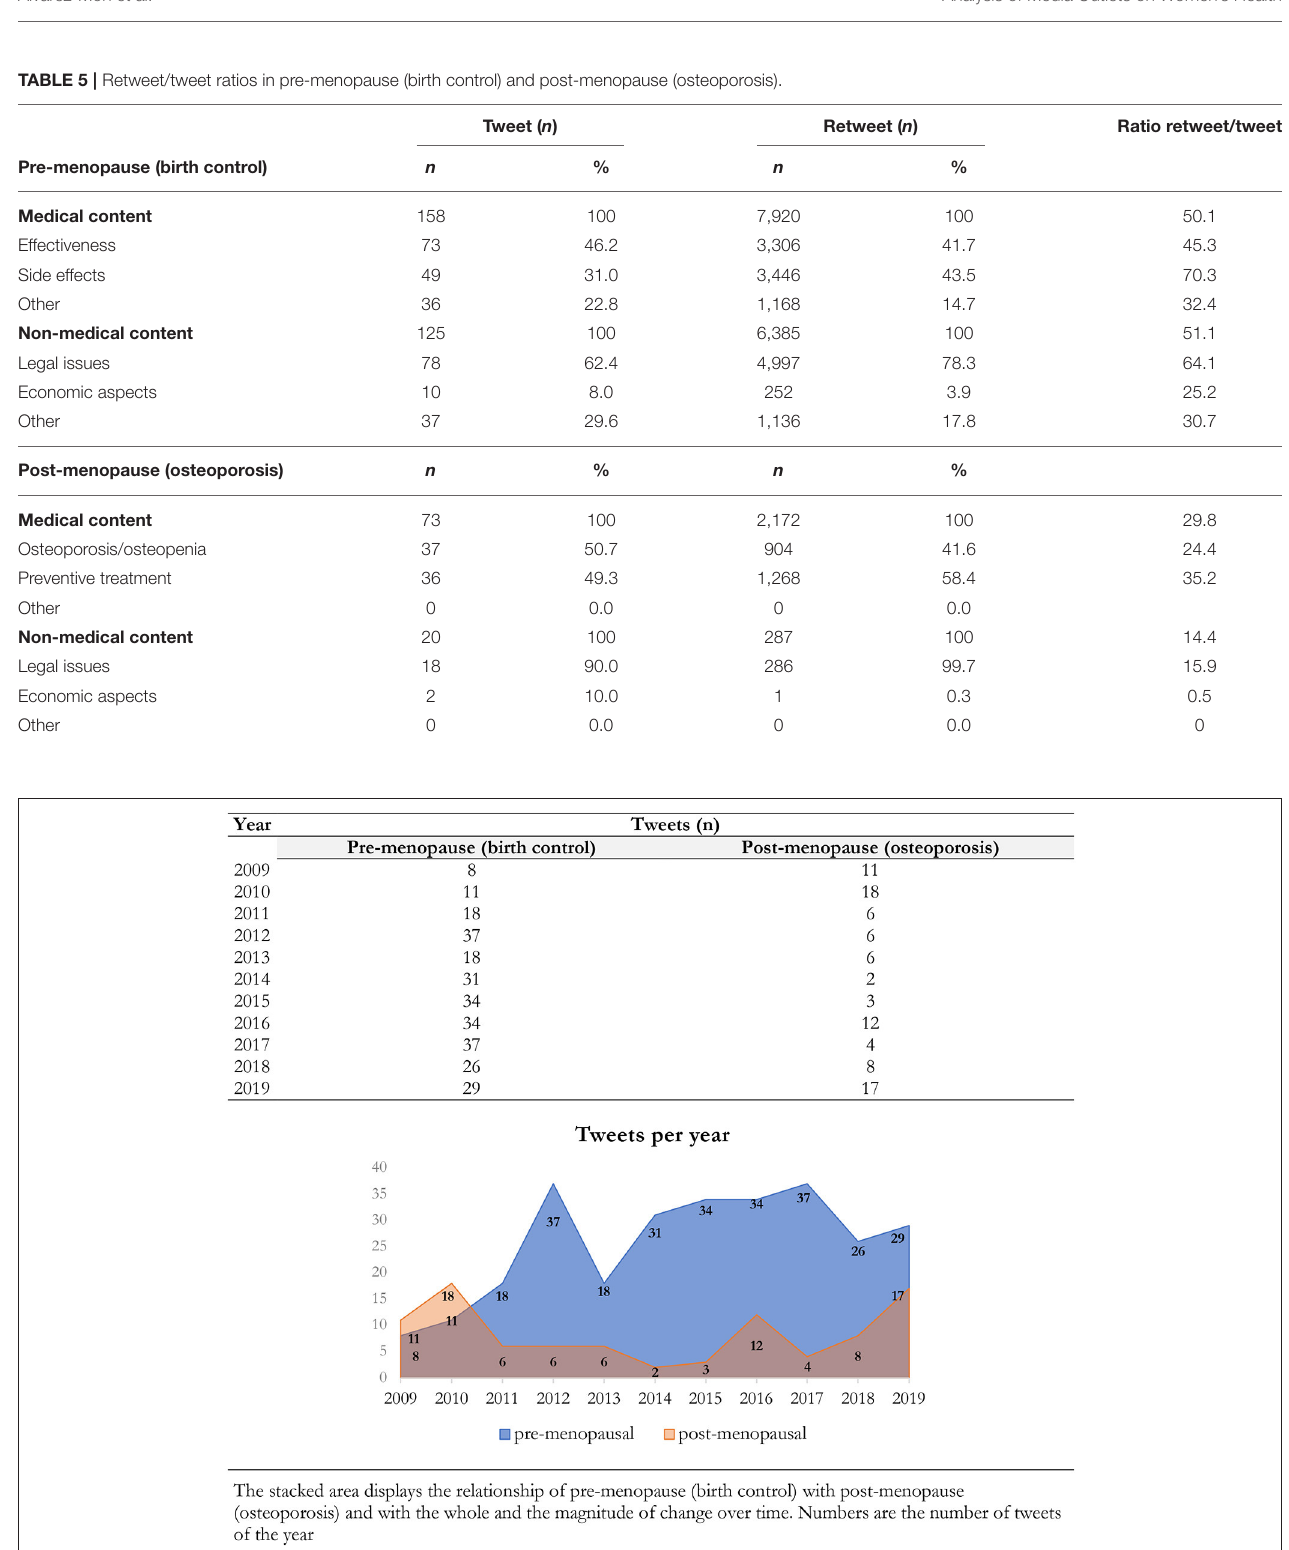
FIGURE 1 | Comparison of the temporal trend over 11 years of tweets between pre-menopause (birth control) and post-menopause (osteoporosis) treatments. The stacked area displays the relationship of pre-menopause (birth control) with post-menopause (osteoporosis) and with the whole and the magnitude of change over time. Numbers are the number of tweets of the